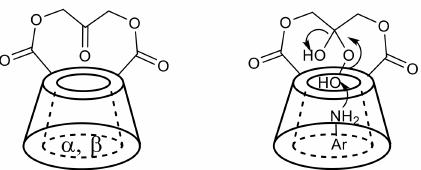
Figure 2. Cyclodextrin ketone catalysts ( left ); proposed mechanism for the catalysis ( right